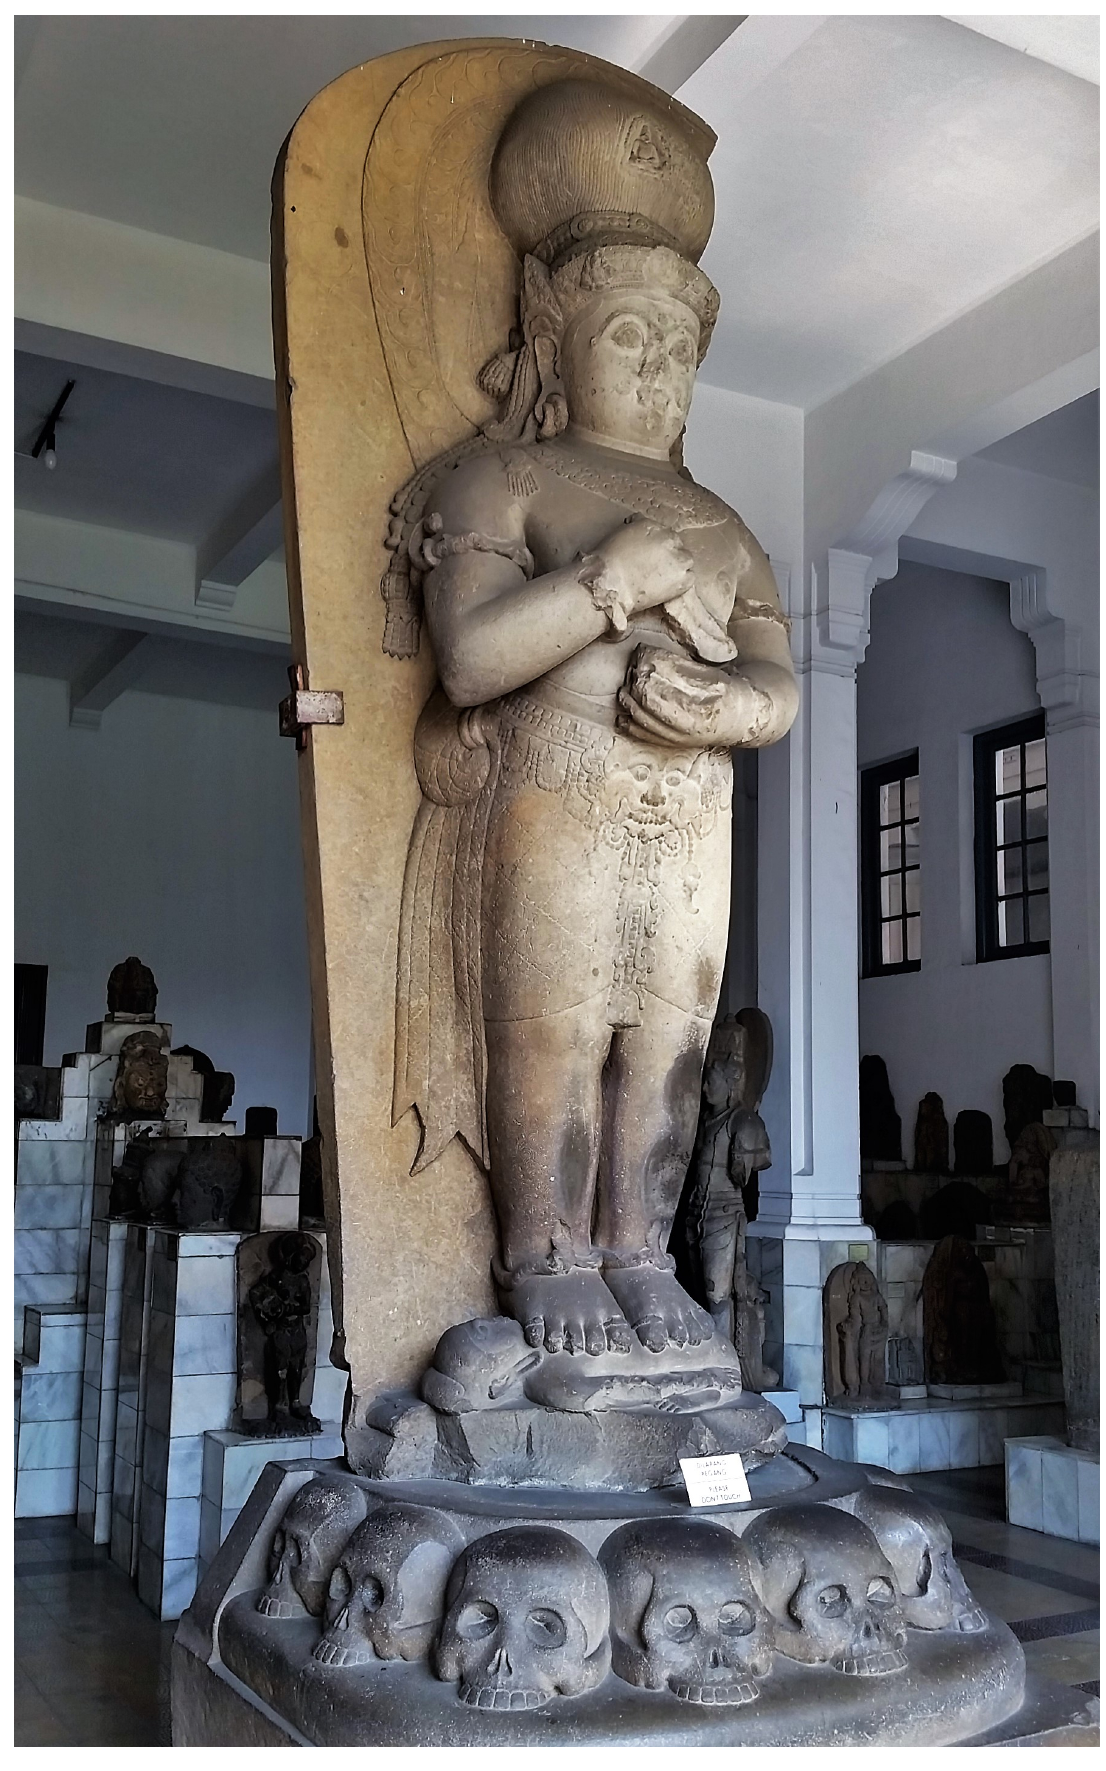
Figure 4 Monumental Vajramahākāla (not Bhairava or *Pañjaranātha) excavated from Padang Roco, West Sumatra (detail). Siṅhasāri period, circa 1289–1292. National Museum of Indonesia Inv. 6470. Licence: CC BY-SA 2.0. Source: